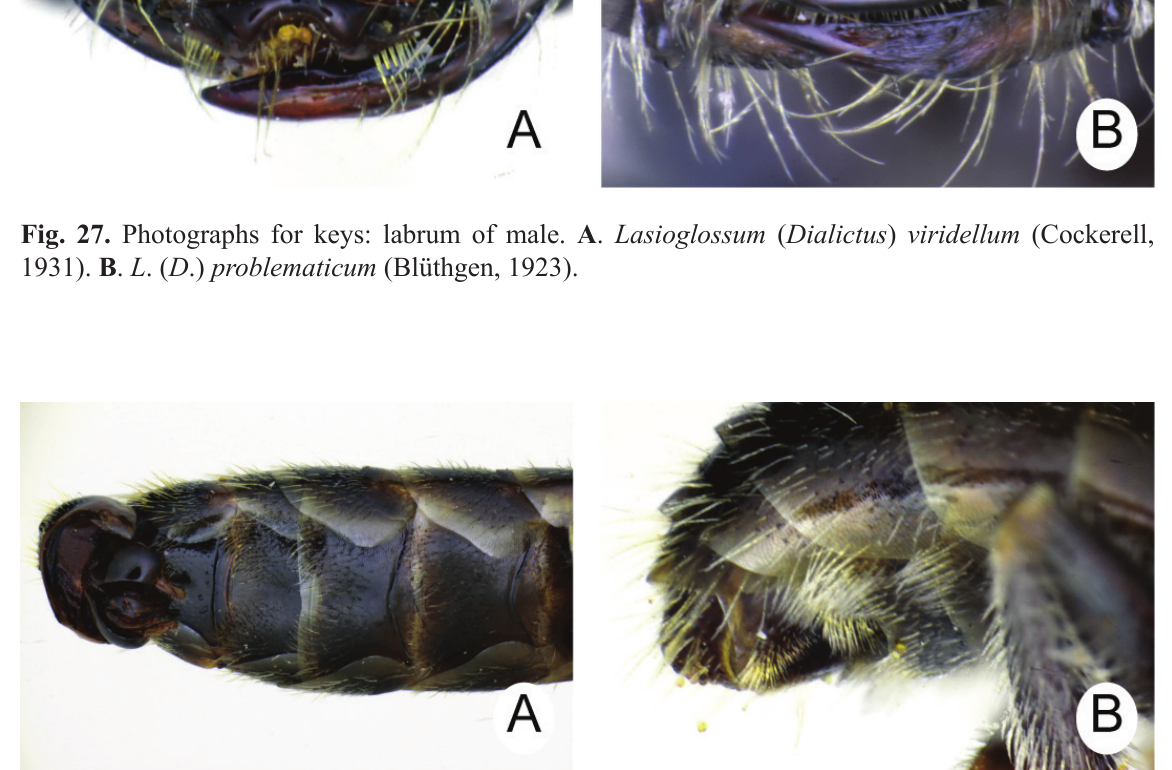
Fig. 28. Photographs for keys: hairs on metasomal sterna of male. A . Lasioglossum ( Dialictus ) miyabei Murao et al ., 2006. B . L . ( D .) meakanense Murao &